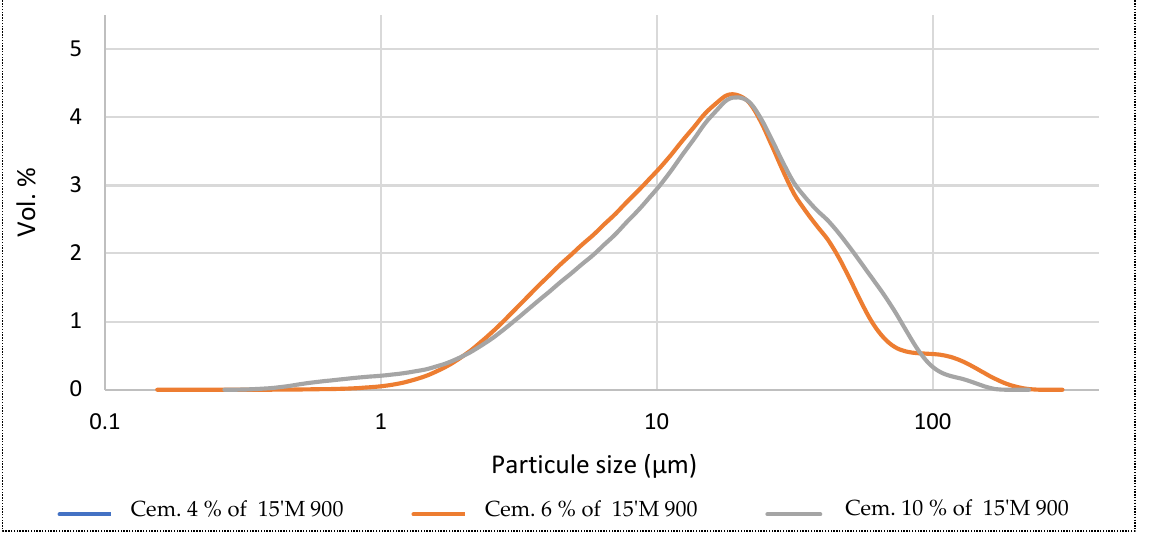
imum peak at 80.074 mm.